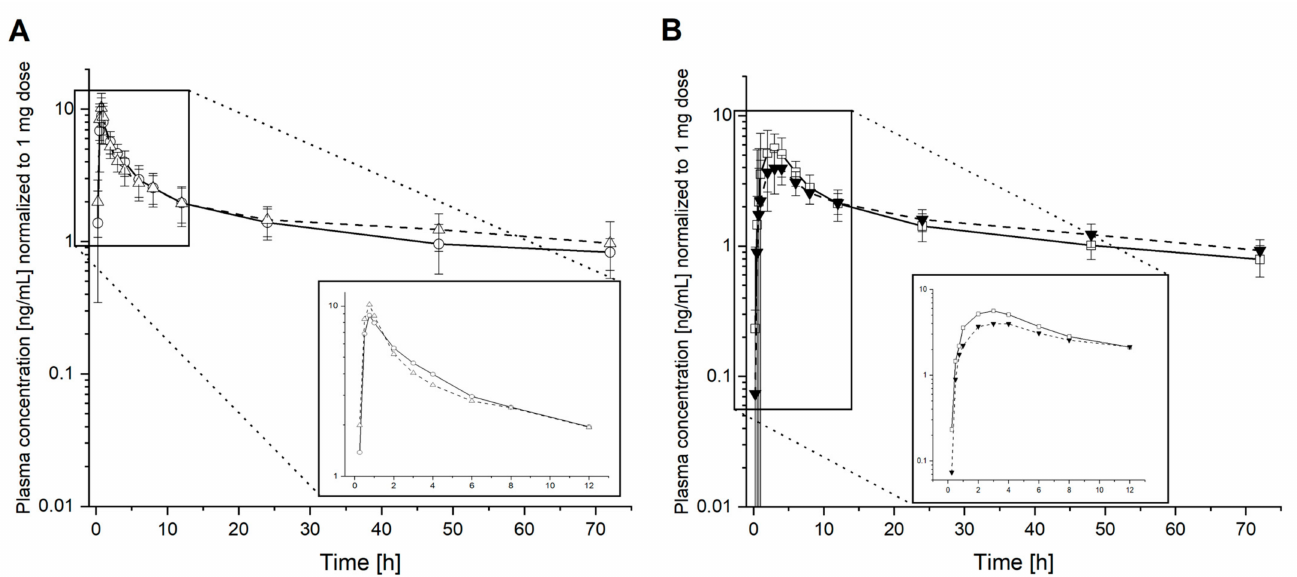
Figure 2. Normalized pharmacokinetic profiles. Efavirenz plasma concentrations vs. time curves of efavirenz admin- istered in a dissolved state ( A ) in intervention 2 (dissolved amorphous solid dispersions (ASD) of efavirenz 50 mg, and intervention 3 (solution of efavirenz 3 mg, (cid:52) ); as well as efavirenz administered in a solid-state ( B ) in intervention 1 (ASD of efavirenz 50 mg, (cid:3) ) and the marketed formulation (50 mg, (cid:72) ) [18] in B are shown. Error bars: standard